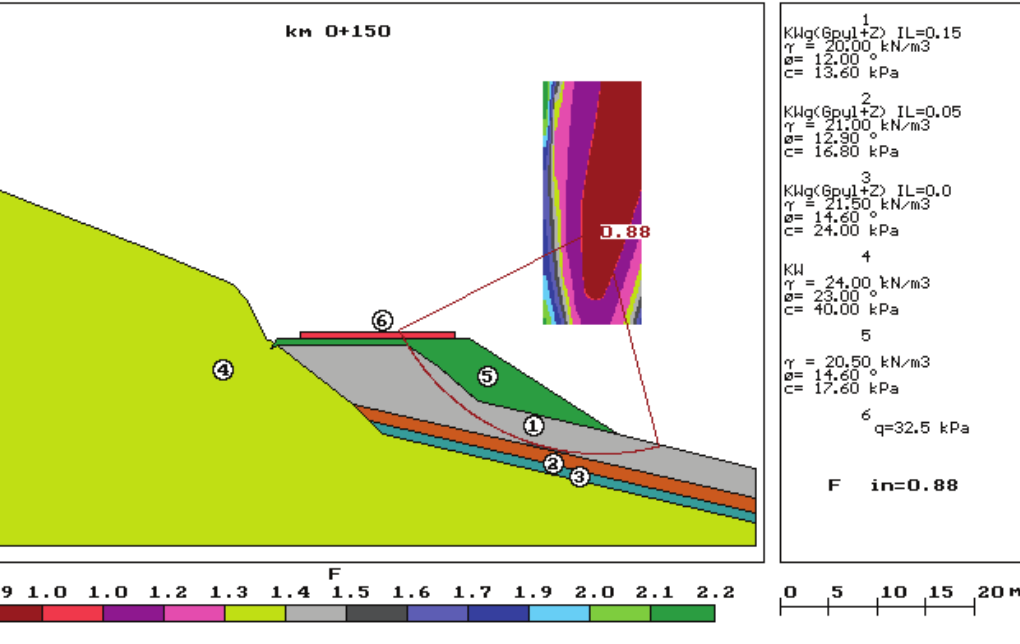
Figure 3. Bolków ring road, cross section of km 0 + 150.02: stability according to EC7 of embankment made of cohesive soil, along with the substrate